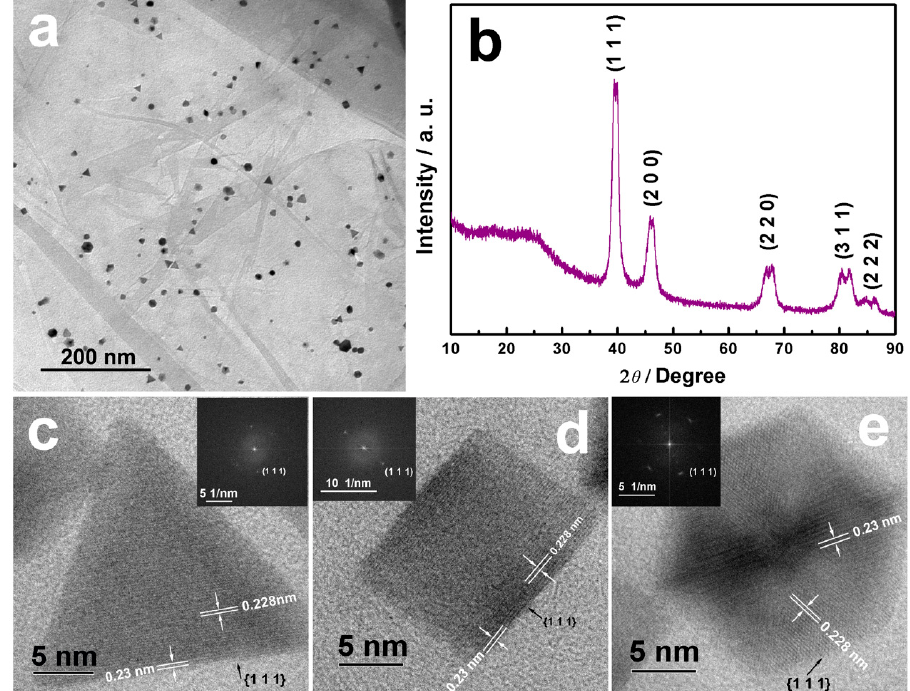
Figure 1. ( a ) TEM image, ( b ) XRD pattern, and ( c – e ) high resolution TEM images (including FFT